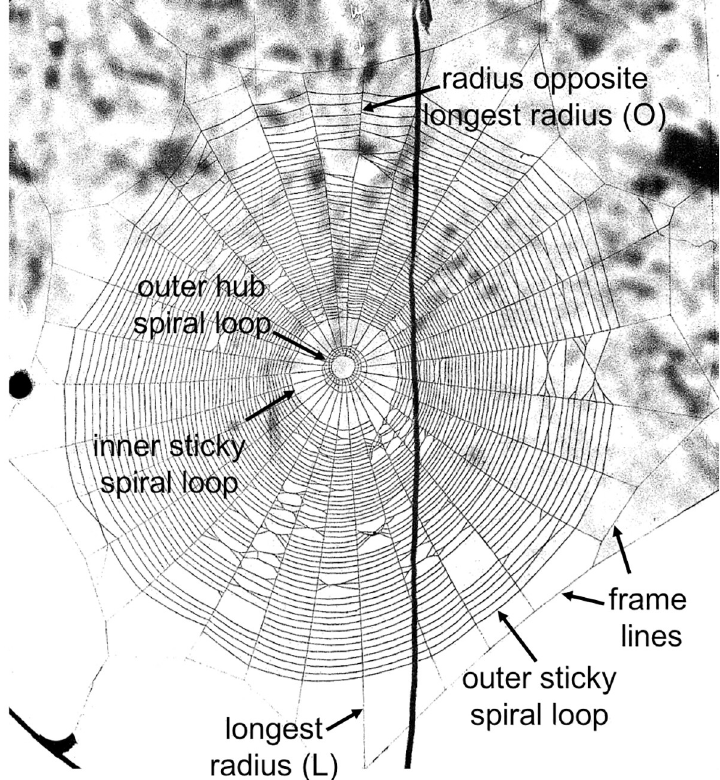
Fig 1. Orb web of a mature Leucauge argyra female built in the field with web measurements labeled.